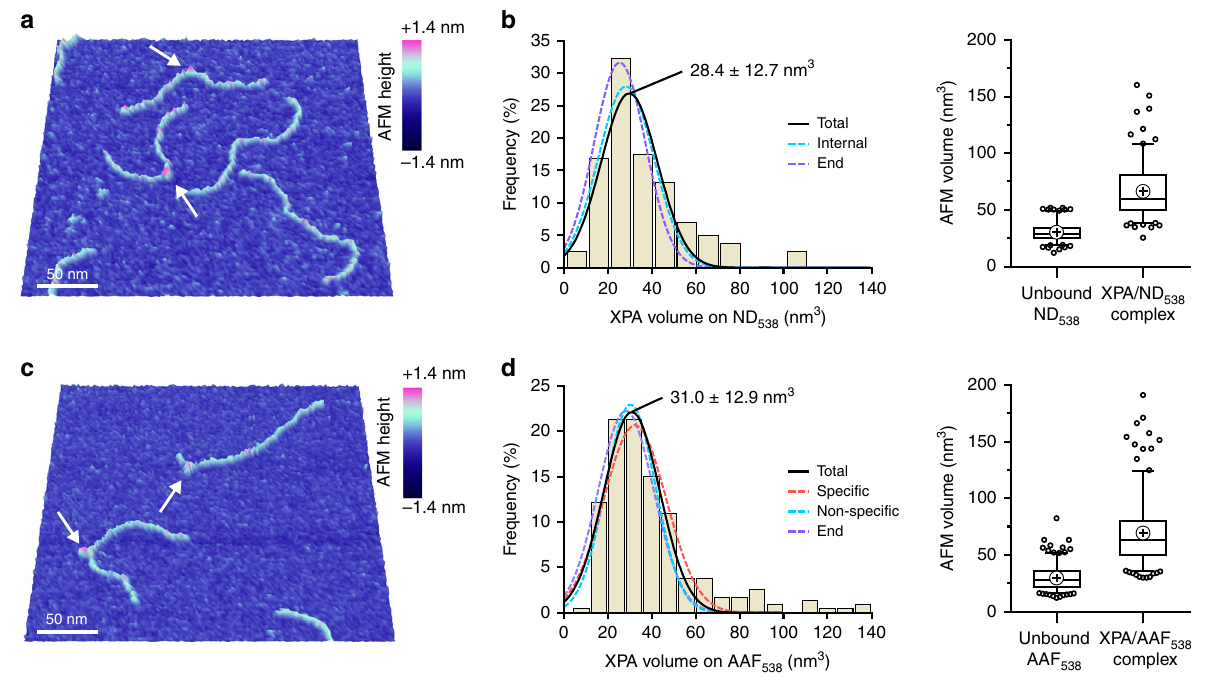
Fig. 3 XPA binds non-damaged DNA and dG-C8-AAF modi fi ed DNA as a monomer. a, c Representative 3D AFM image of XPA bound to 538 bp non- damaged DNA ( a , ND 538 ) or 538 bp DNA with a single dG-C8-AAF adduct at 30% from one end ( c , AAF 538 ). White arrows point to XPA bound to DNA. b Left, histogram showing distribution of AFM volumes of all XPA molecules bound to ND 538 ( n = 161 particles) with Gaussian fi t (solid black line, labeled with mean ± s.d. of the distribution). AFM volume corresponds to 26.7 ± 12.9 kDa, using the standard shown in Fig. 2b. Dashed cyan line, Gaussian fi t to the sub-fraction of non-speci fi cally bound XPA (i.e., all internal complexes, n = 108); centered at 29.9 nm 3 (s.d. 12.8 nm 3 ), corresponding to 28.0 ± 13.0 kDa. Dashed purple line, Gaussian fi t to the sub-fraction of XPA bound at DNA ends ( n = 53); centered at 25.5nm 3 (s.d. 11.7nm 3 ), corresponding to 24.1±12.0kDa. Right, box and whisker plots (5-95 percentile) of unbound DNA and total complex volume measurements. d Left, histogram showing the distribution of AFM volumes of all XPA proteins ( n = 235 particles) bound to AAF 538 with a Gaussian fi t (solid black line). The AFM volume corresponds to 29.0±13.1kDa. Dashed red line, Gaussian fi t to the sub-fraction of XPA bound between 20 and 40% of the DNA contour length ( “ speci fi c, ” n = 58); centered at 32.4nm 3 (s.d. 14.4nm 3 ), corresponding to 30.2±14.4kDa. Dashed cyan line, Gaussian fi t to the sub-fraction of XPA bound internally but at positions away from the lesion ( “ non-speci fi c, ” n = 84); centered at 30.5nm 3 (s.d. 11.4nm 3 ), corresponding to 28.5±11.8kDa. Dashed purple line, Gaussian fi t to the sub-fraction of XPA bound at DNA ends ( n = 51); centered at 28.3 nm 3 (s.d. 13.0nm 3 ), corresponding to 26.6±13.2kDa. Right, box and whisker plots (5-95 percentile) of unbound DNA and total complex volume